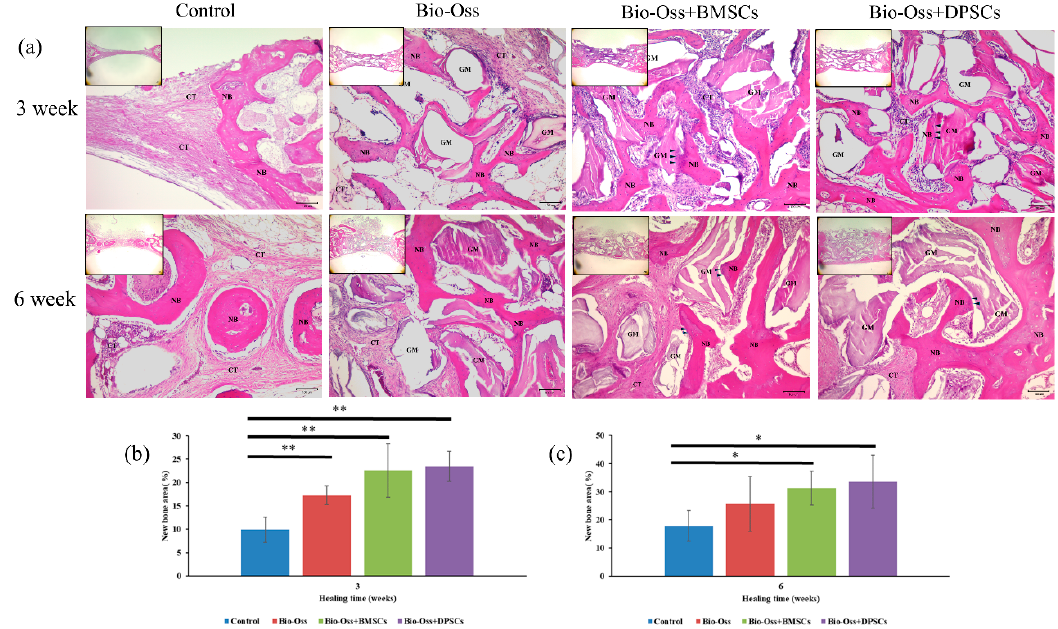
Figure 8. ( a ) Hematoxylin and eosin (H&E) stained images of bone defect regions at 3 and 6 weeks in control, Bio-Oss, Bio-Oss + BMSC, and Bio-Oss + DPSC groups. The black arrowheads indicate osteoblasts at the interface between the bone grafting materials and the newly-formed bone. New bone area percentages in defect region at ( b ) 3 weeks and ( c ) 6 weeks after surgery, as assessed by histomorphometric analyses. (NB = new bone; GM = graft material; CT = connective tissue; H&E = hematoxylin and eosin. Scale bars = 100 m.) (* p < 0.05, ** p < 0.01.).